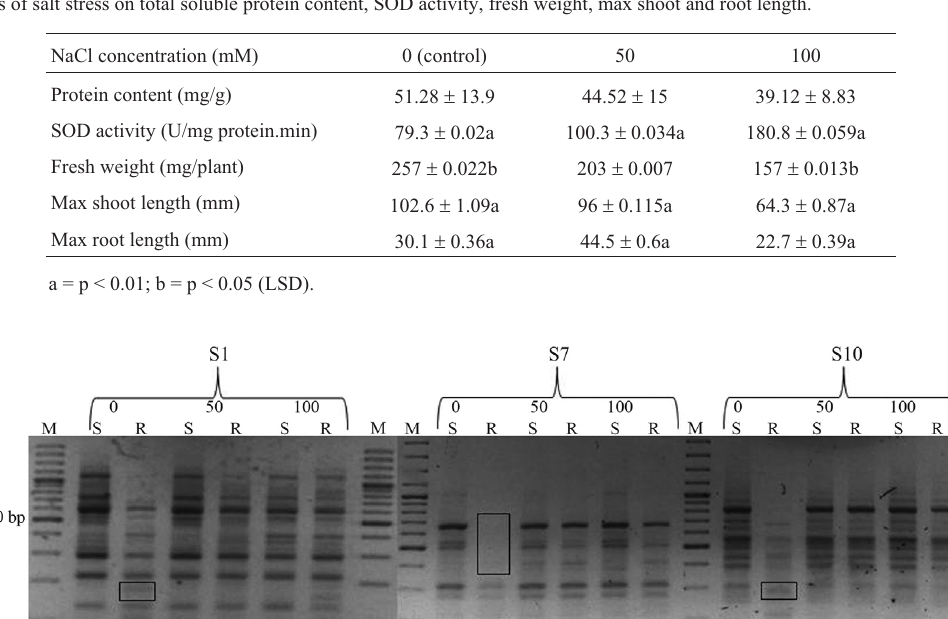
Table 1 - Effects of salt stress on total soluble protein content, SOD activity, fresh weight, max shoot and root length.